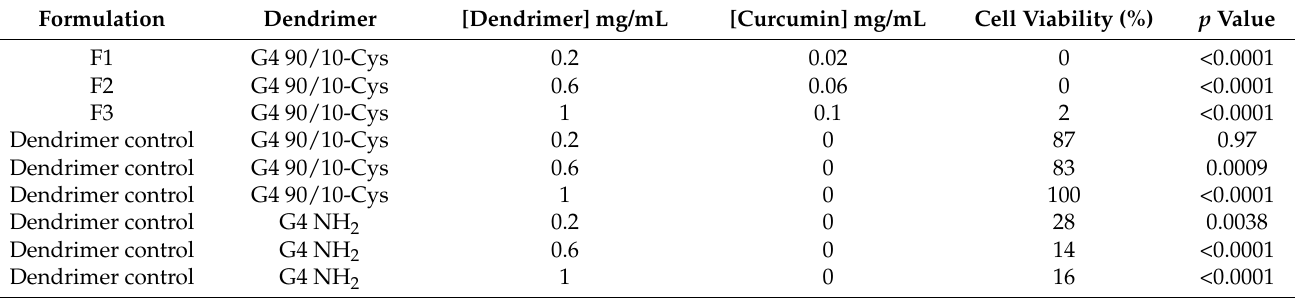
Table 2. Effect of F1, F2 and F3 on U87